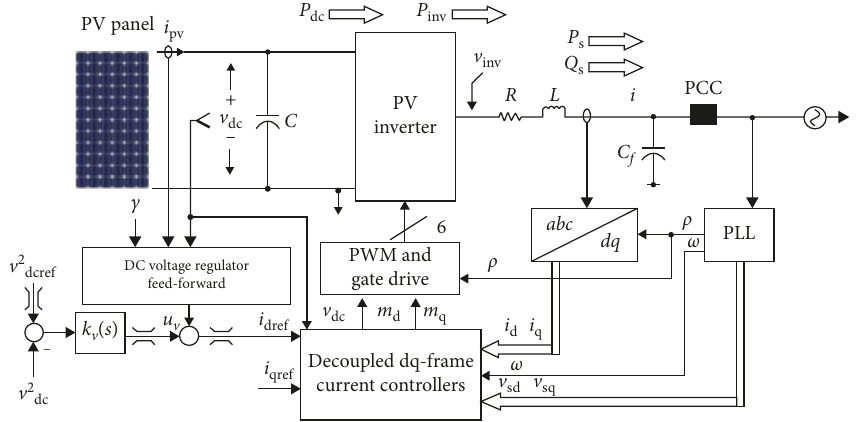
Figure 2: PV system schematic diagram.